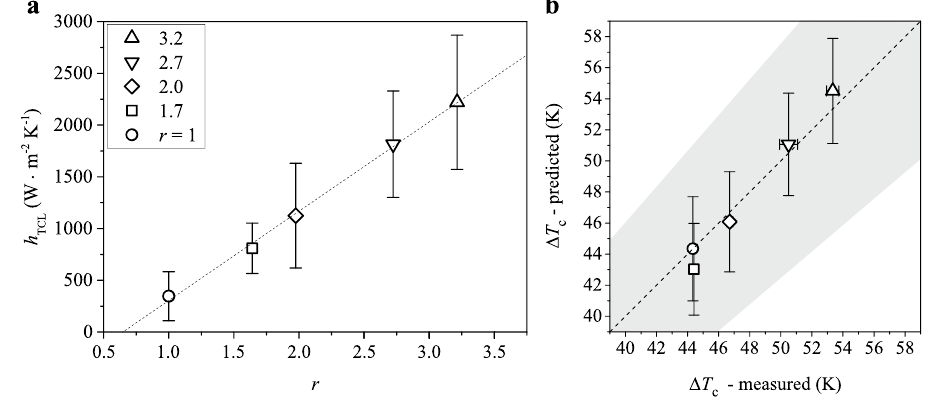
Figure 4. ( a ) Heat transfer coefficient at the three-phase contact line h TCL versus surface roughness r . ( b ) Critical heat flux temperature T c predicted using Eqn. 5 versus the measured values for substrates with different r . The shaded area indicates a 15% deviation from the measured